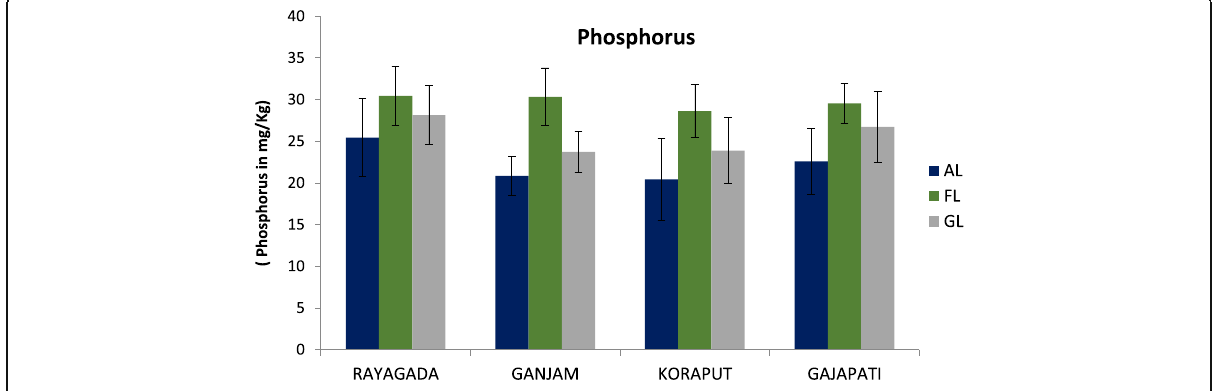
Fig. 5 Available phosphorus percentage with means under different habitat conditions across four